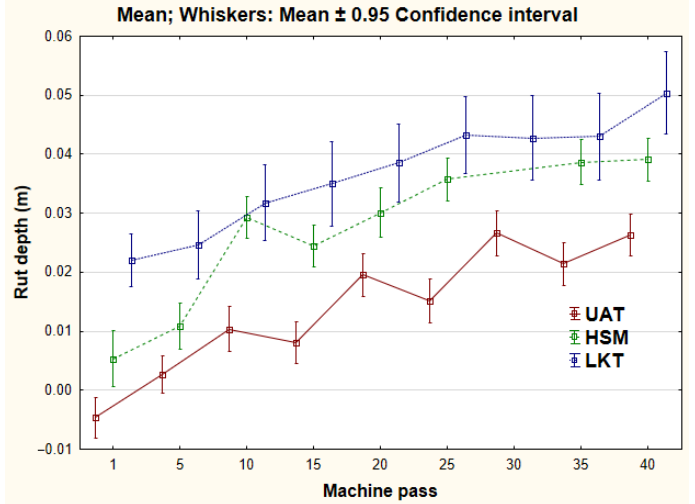
Figure 4. The RMSE values for x, y, and z axes and for individual plots, % represents recorded images percentage from recommended number of images, x symbol represents the mean, horizontal line median, vertical lines depict 1st and 4th quartiles, and boxes contain 2nd and 3rd quantiles divided by median lines.